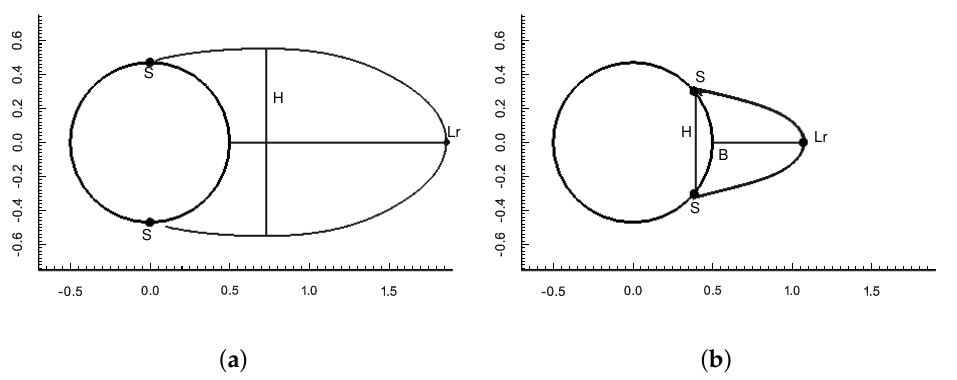
Figure 5. Mean wake recirculation zone scheme ( a ) sub-critical regime, ( b ) super-critical